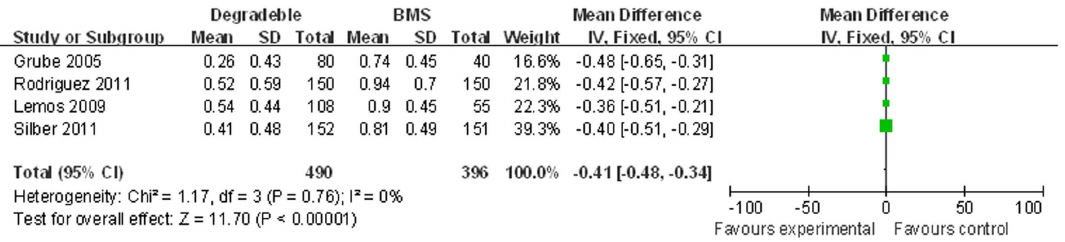
Figure 7. Standardized mean difference (SMD) for ISLL in patients treated with BP-DES vs. BMS.